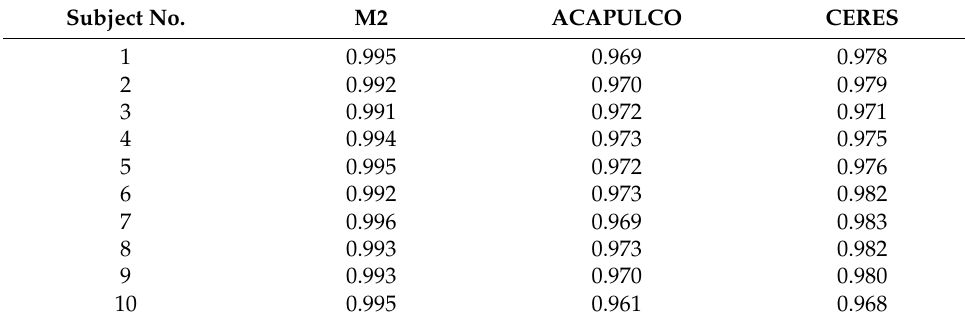
Table 12. SP comparison between the approaches, in DLBS